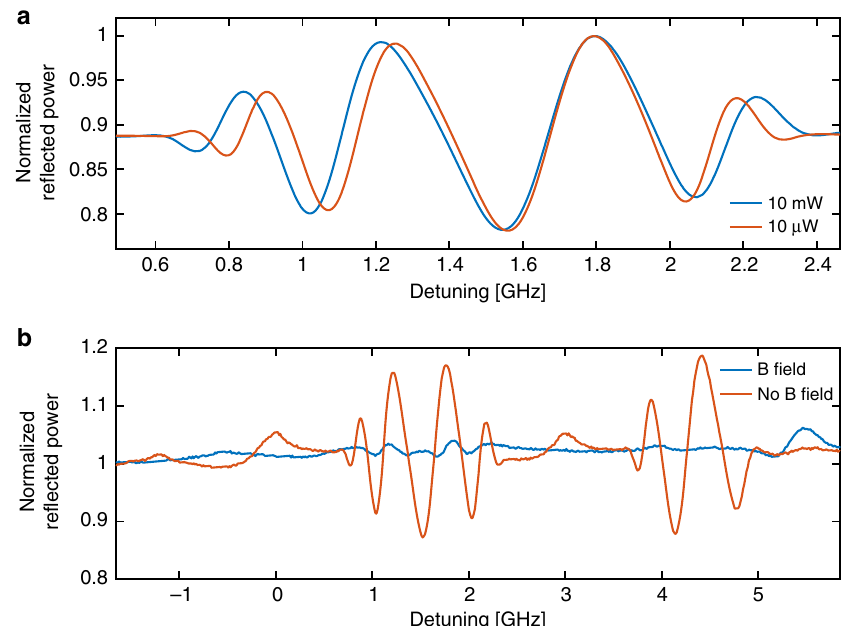
Fig. 4 ADOE response as function of laser power and external magnetic fi eld. a Normalized fi rst-order re fl ected power as a function of frequency detuning of an atomic diffractive grating, with incident power of 10 mW (blue line) and 10 µ W (red line). A portion of the spectra corresponding to spectroscopic data between the two absorption lines of 85 Rb is shown here. b Normalized fi rst-order re fl ected power as a function of frequency detuning of an atomic diffractive grating for the case where a ~300 gauss magnetic fi eld is applied to the grating (blue lines) and in the absence of such fi eld (red